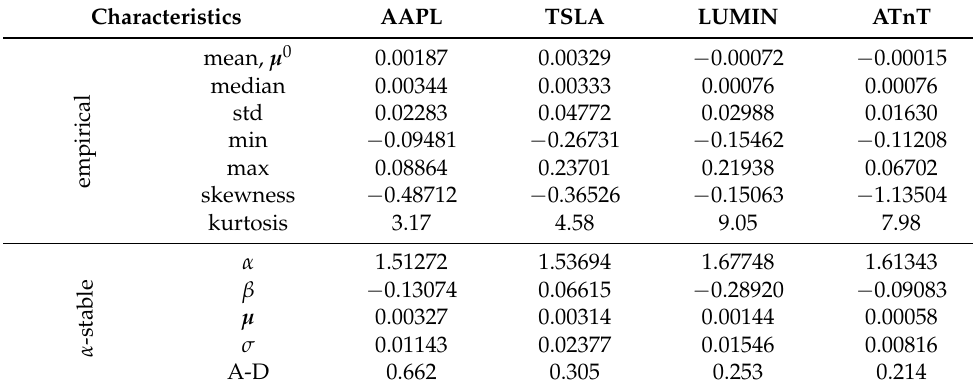
Table 1. Marginal characteristics of stock returns.